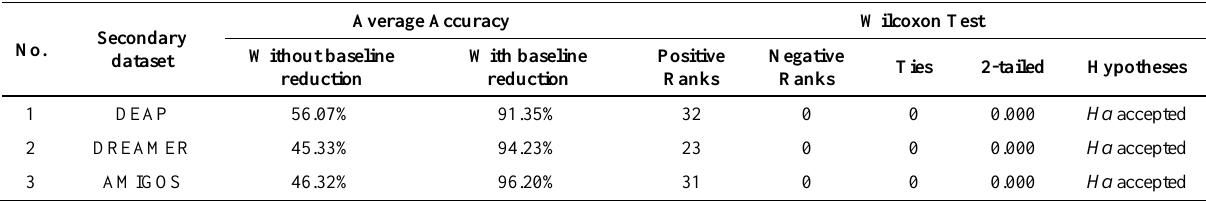
Table 9. Wilcoxon test results for applying the baseline reduction in the Continuous Capsule Network method for four emotion